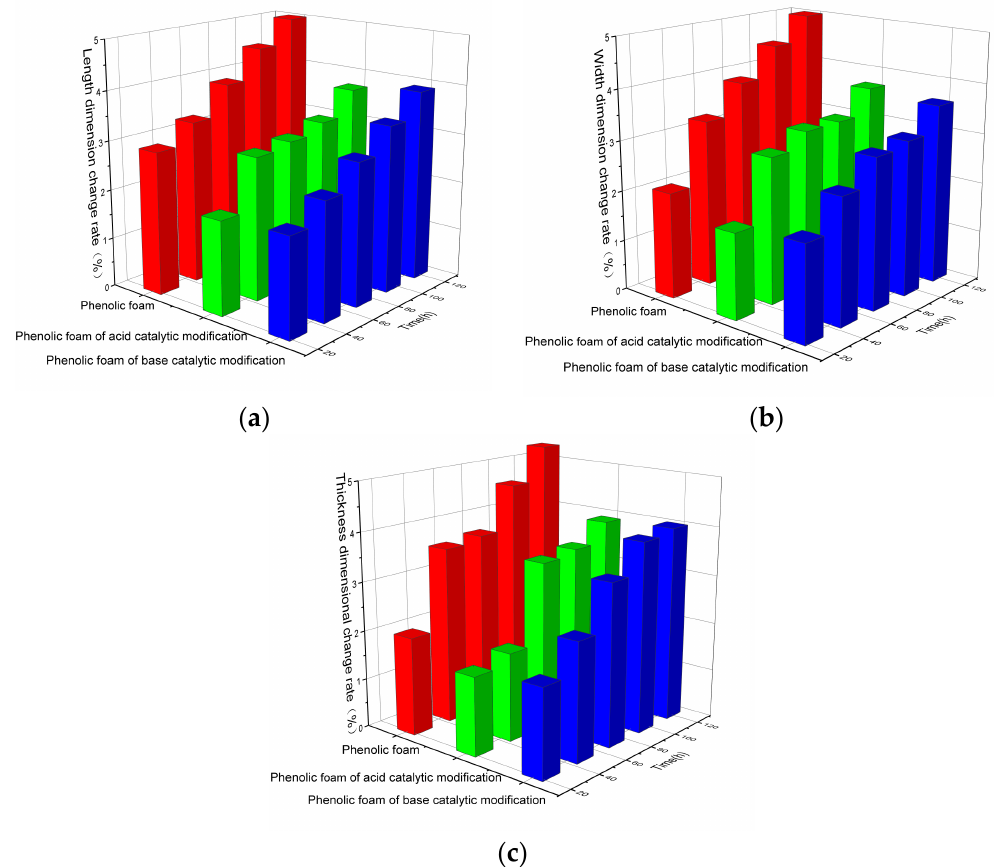
Figure 5. ( a ) Length dimension change rate of phenolic foam and modified phenolic foam; ( b ) width dimension change rate of phenolic foam and modified phenolic foam; ( c ) thickness dimension change rate of phenolic foam and modified phenolic